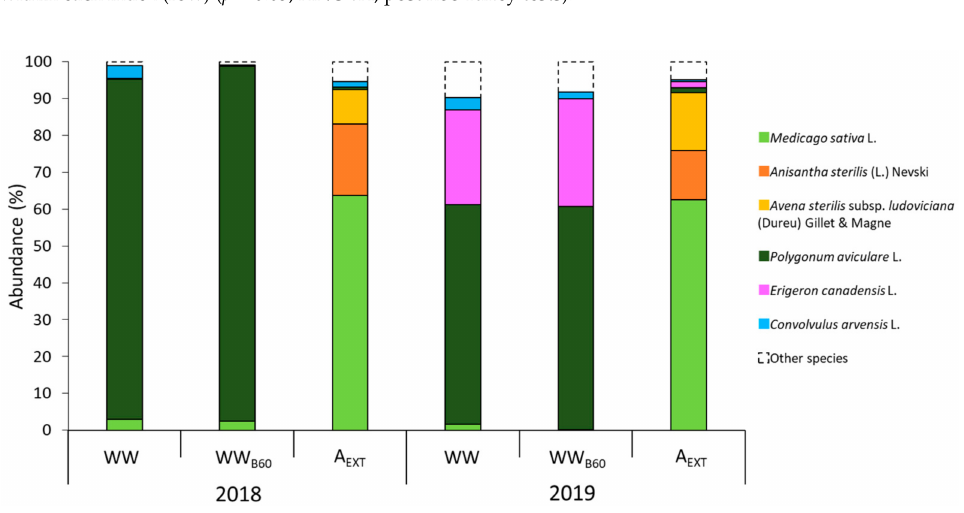
Figure 3. The six species that contributed at least 3% abundance for the three management systems across the two seasons. WW, alfalfa followed by wheat for 2 years, control; WW B60 , alfalfa followed by single biochar application followed by wheat for 2 years; A EXT , alfalfa extended for 2